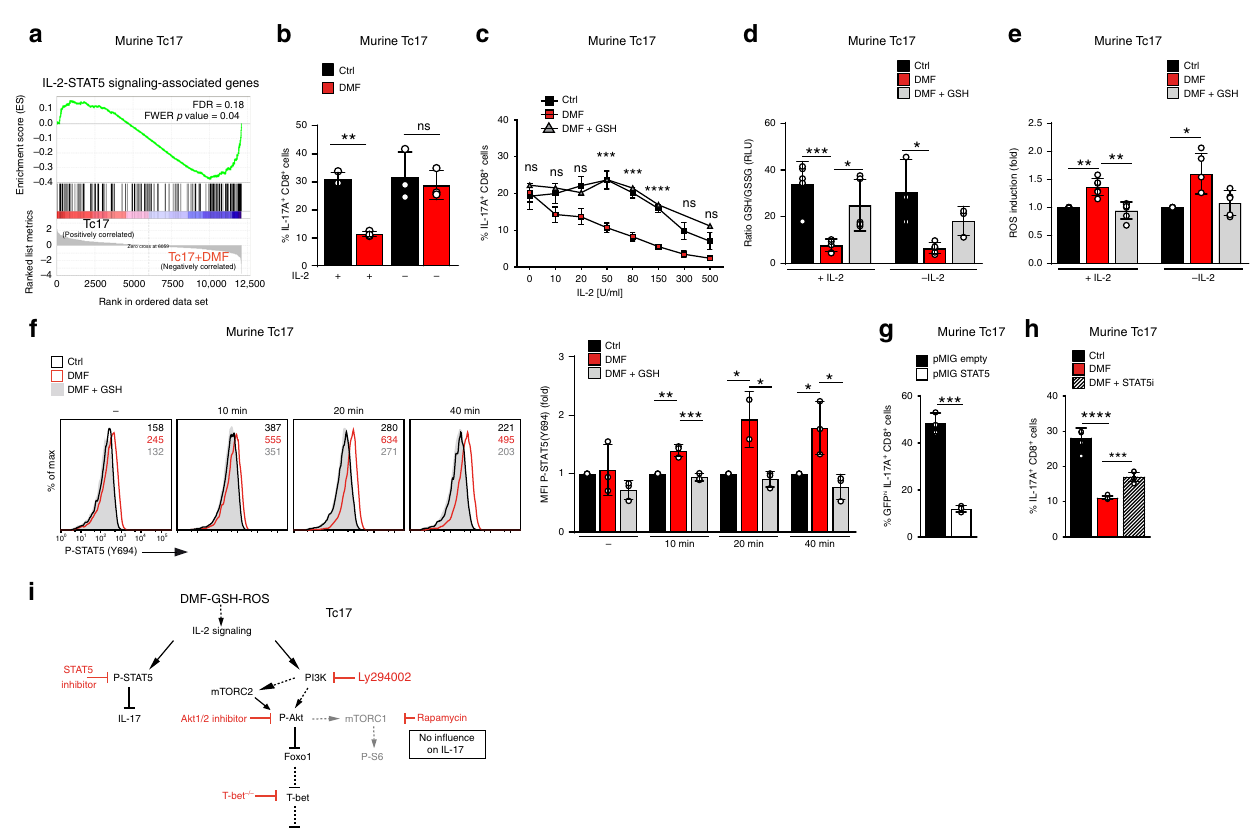
Fig. 4 DMF interferes with IL-2-STAT5 signaling to limit IL-17 expression in Tc17 cells. a GSEA of genes associated with IL-2-STAT5-signaling in murine Tc17 cells ± DMF (data set from Fig. 2a) based on MSigDBv6.1. b , c Flow cytometry of IL-17A in murine Tc17 cells differentiated for 72 h ± IL-2, ± DMF or DMF + GSH. Signi fi cances in graph are shown for Ctrl vs DMF (mean ± s.d.). d GSH/GSSG ratio in murine Tc17 cells differentiated for 2 h ± rhIL-2, ± DMF or DMF + GSH. e Flow cytometry of ROS levels determined by CM-H 2 DCFDA staining in murine Tc17 cells differentiated for 2 h ± IL-2, ± DMF or DMF + GSH (fold MFI normalized to the respective control, which was arbitrarily set to 1). f Flow cytometry of phospho(P)-STAT5(Y694) in murine Tc17 cells differentiated for 48 h, rested, then activated with IL-2 ± DMF or DMF + GSH for the indicated time (fold MFI normalized to control, which was arbitrarily set to 1). g , h Flow cytometry of IL-17A in murine Tc17 cells after retroviral transduction with constitutive-active P-STAT5 (pMIG STAT5) or GFP vector alone (pMIG empty) g or in Tc17 cells after 72 h of differentiation ± DMF, ± 35 µ M STAT5 inhibitor (STAT5i) h . i Schematic in fl uence of DMF-GSH-ROS on IL-2 signaling, leading to IL-17 and ROR γ t suppression in Tc17 cells. Modi fi ed from 43 . Bars show mean ± s.d. from seven to fi ve e , six h , or fi ve to three d or three b , c , f , g combined experiments; individual values are plotted. In g *** p < 0.001, evaluated by two-tailed, unpaired t -test, in b – d , f , h * p < 0.05, ** p < 0.01, *** p < 0.001, by one-way ANOVA followed by Tukey ’ s HSD multiple comparison test, in e * p < 0.05, ** p < 0.01 by one-way Welch ’ s ANOVA with Games-Howell multiple comparison